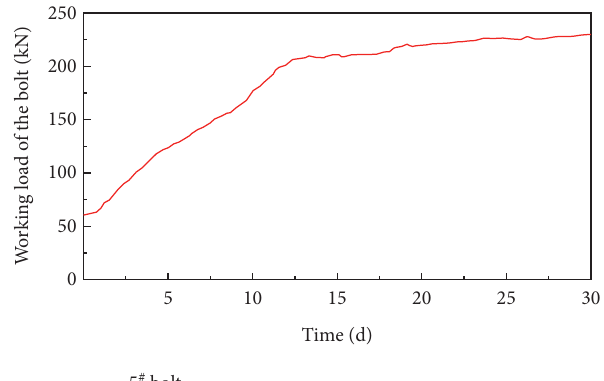
Figure 19: Working resistance-time variation curve of the 5 #